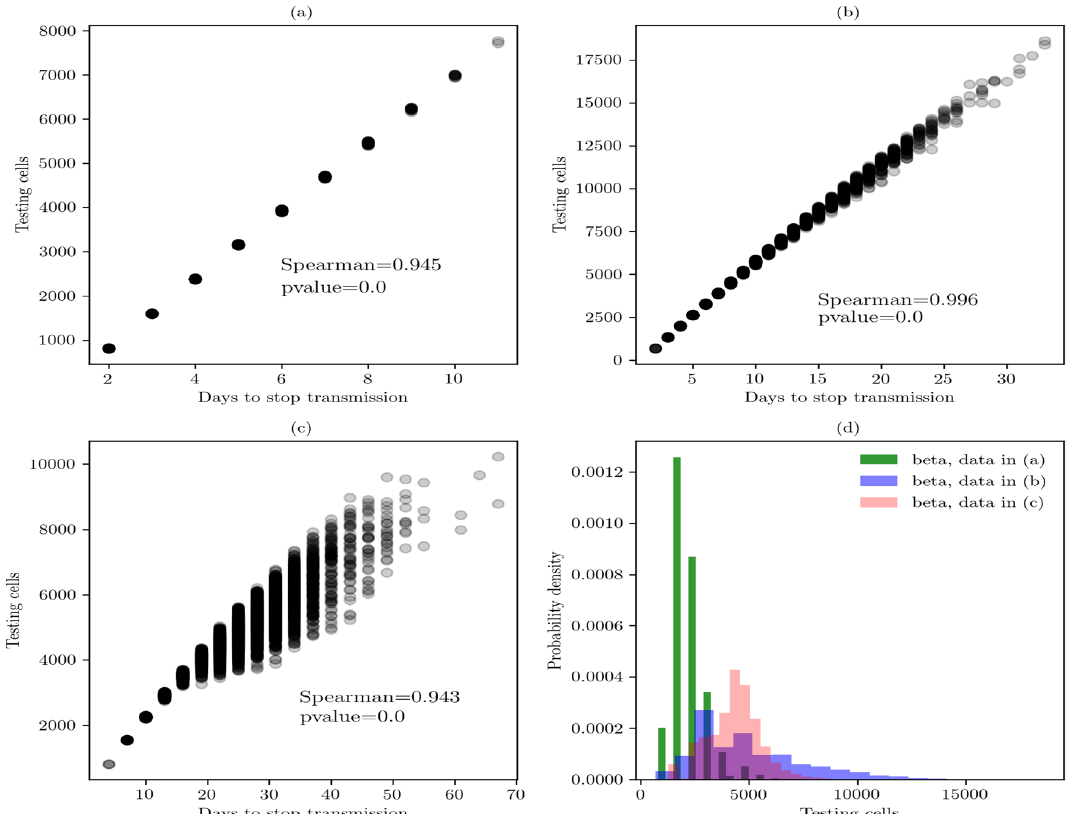
Figure 5. Sensitivity analysis based on scatterplots in the array of (30, 30). ( a ) Daily testing and 90% of random sample. ( b ) Twice a week testing and 90% of random sample. ( c ) Daily testing and 75% of random sample. ( d ) Distribution fitting of the cost for the testing strategy in the three cases. Data in ( a ), ( b ), and ( c ) are best described by a beta distribution that shows a probability density function of the form α − 1 ( 1 − x ) b − 1 0 < x < 1 , a > 0 , b > 0 . f ( x , a , b ) = γ( a + b ) x γ( a )γ( b ) , for